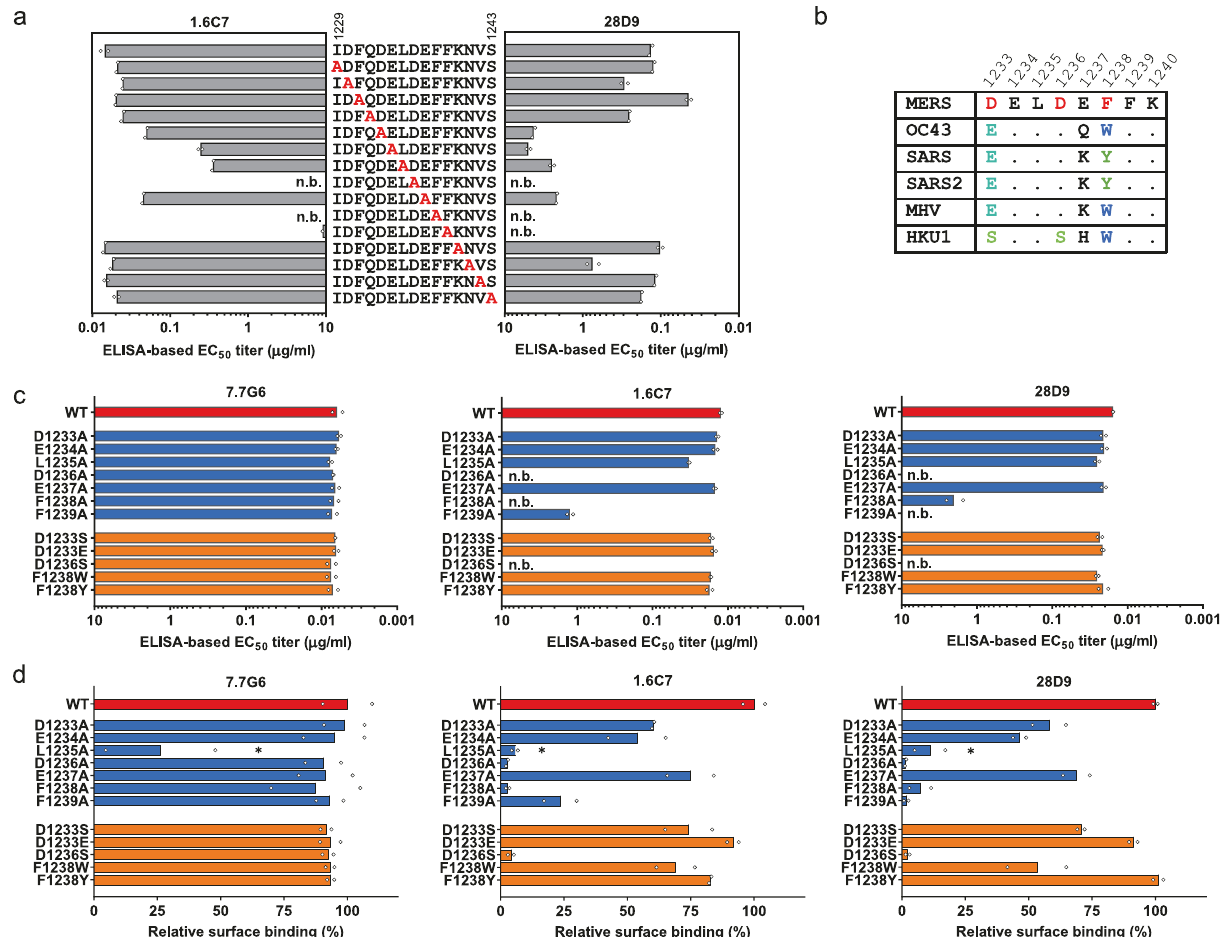
Fig. 4 Fine mapping the 1.6C7 and 28D9 antibody binding sites on the spike protein by mutagenesis. a ELISA-based epitope alanine mutagenesis on the 15-mer spike peptide fragment comprising the linear 1.6C7 and 28D9 epitope, shown by half-maximum effective concentration (EC 50 ) titers ( μ g/ml). The average from two independent experiments performed is shown. Source data are provided as a Source Data fi le. b Sequence alignment of 1.6C7/28D9 epitope region of MERS-CoV, HCoV-OC43, SARS-CoV, SARS-CoV-2, MHV and HCoV-HKU1. c Spike protein ectodomain single site mutagenesis to delineate 1.6C7 and 28D9 antibody binding sites. ELISA-based EC 50 titers ( μ g/ml) of 1.6C7/28D9 binding to MERS-S ecto mutants containing single amino acid substitutions in the core epitope region are indicated on the left. Anti-MERS-S1 control antibody 7.7G6 was used to control the expression level of all mutants. n.b., no binding. The average from n = 2 biological replicates is shown. Source data are provided as a Source Data fi le. d Binding of 28D9 and 1.6C7 antibodies to cell surface expressing (GFP-tagged) MERS-S mutants containing single amino acid substitutions in the core epitope region detected by fl ow cytometry. Antibody binding was detected using AlexaFluor 594 conjugated secondary antibody. The relative surface binding was determined by calculating the percentage of GFP + /Alexa Fluor 594 + cells over GFP + cells. Anti-MERS S1 antibody 7.7G6 was used to control the cell surface expression levels of all single-site mutants. The asterisk indicates reduced cell surface expression of the L1235A mutant. n.b., no binding. The average from n = 2 biological replicates is shown. Source data are provided as a Source Data fi